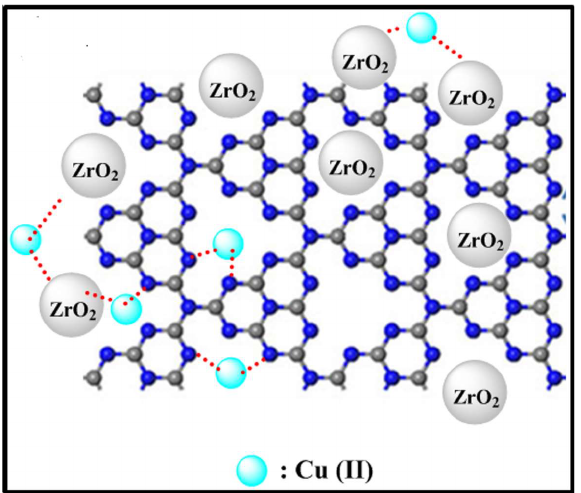
Figure 9. Plausible mechanism for Cu ions adsorption onto Zr-g-C 3 N 4 nanoparticles’ surface.